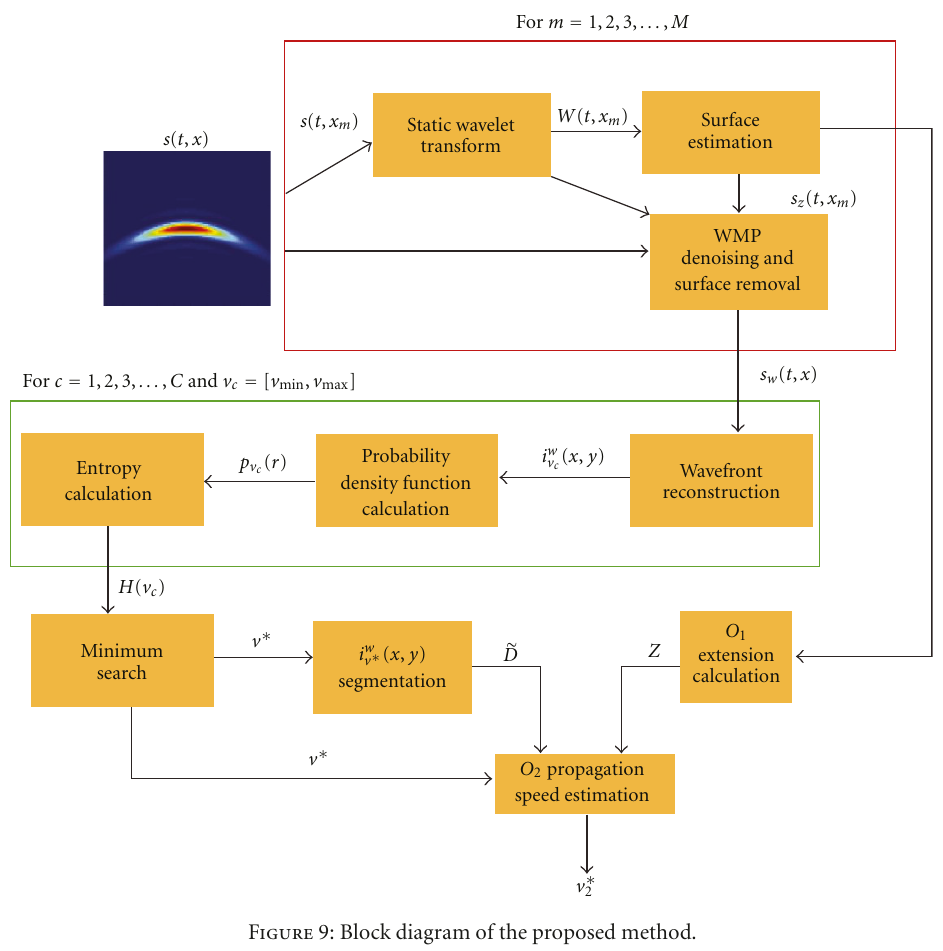
Figure 9: Block diagram of the proposed